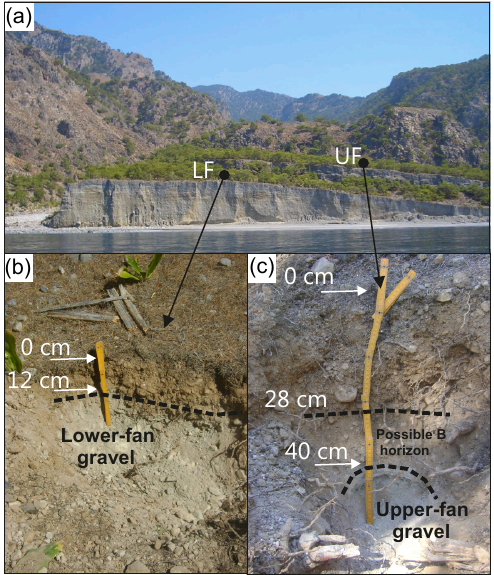
Figure 8. (a) The two alluvial fans with their tree cover ( Pinus bru- tia). Arrows indicate the soil cover that develops on each of the fan surfaces. (b) The soil development on the lower-fan (LF) surface is ∼ 12cm (as indicated by the white arrows). (c) The soil develop- ment on the upper-fan (UF) surface is ∼ 40cm (see white arrows). The fan gravel in both cases is